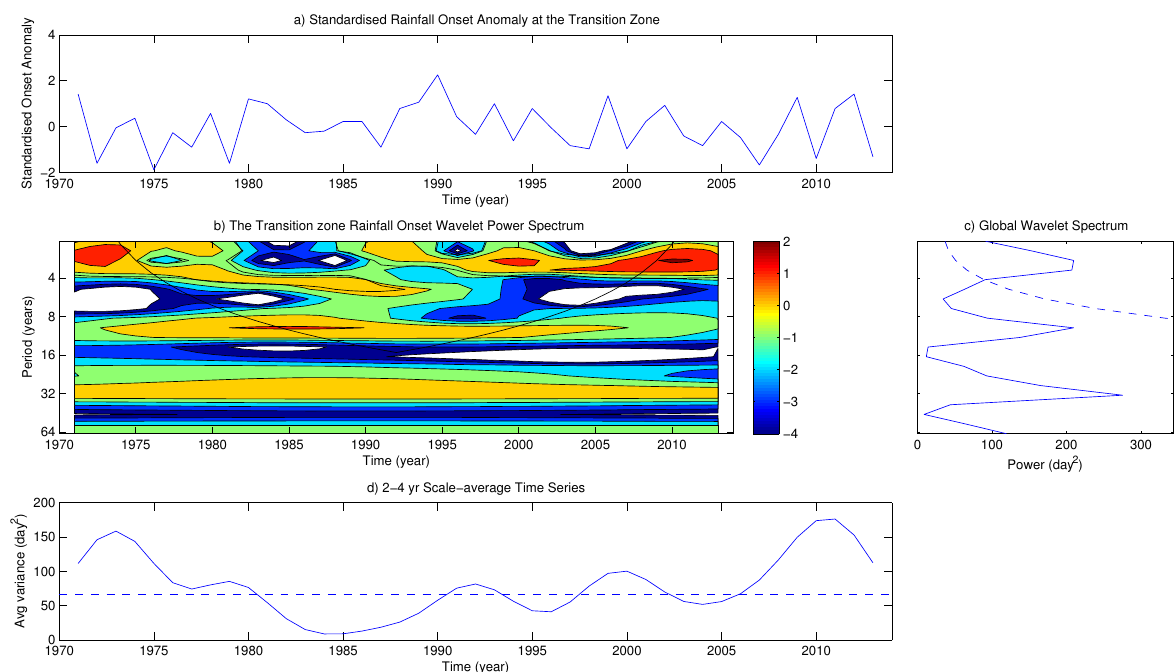
Figure 8. Interannual variability of rainfall onset dates for the transition zone using wavelet analysis. ( a ) Standardized anomaly of onset date; ( b ) as in Figure 6; ( c ) as in Figure 6; ( d ) as in Figure 6; the dashed line shows the 95% confidence